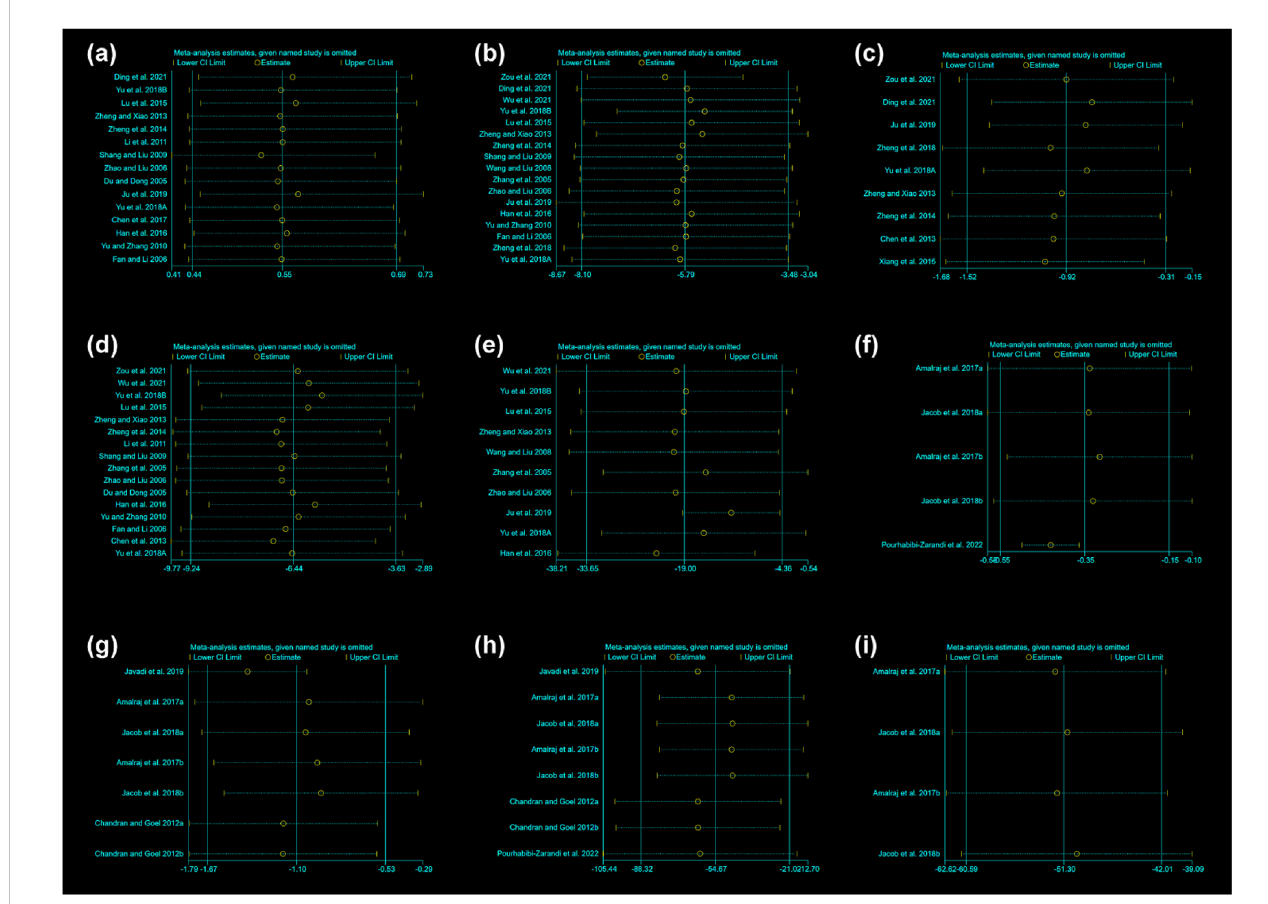
FIGURE 13 Sensitivity Analysis results (A) adverse events of total glucosides of paeony; (B) CRP of total glucosides of paeony; (C) DAS28 of total glucosides of paeony; (D) ESR of total glucosides of paeony; (E) RF of total glucosides of paeony; (F) CRP of curcumin; (G) DAS28 of curcumin; (H) ESR of curcumin; (I) RF of